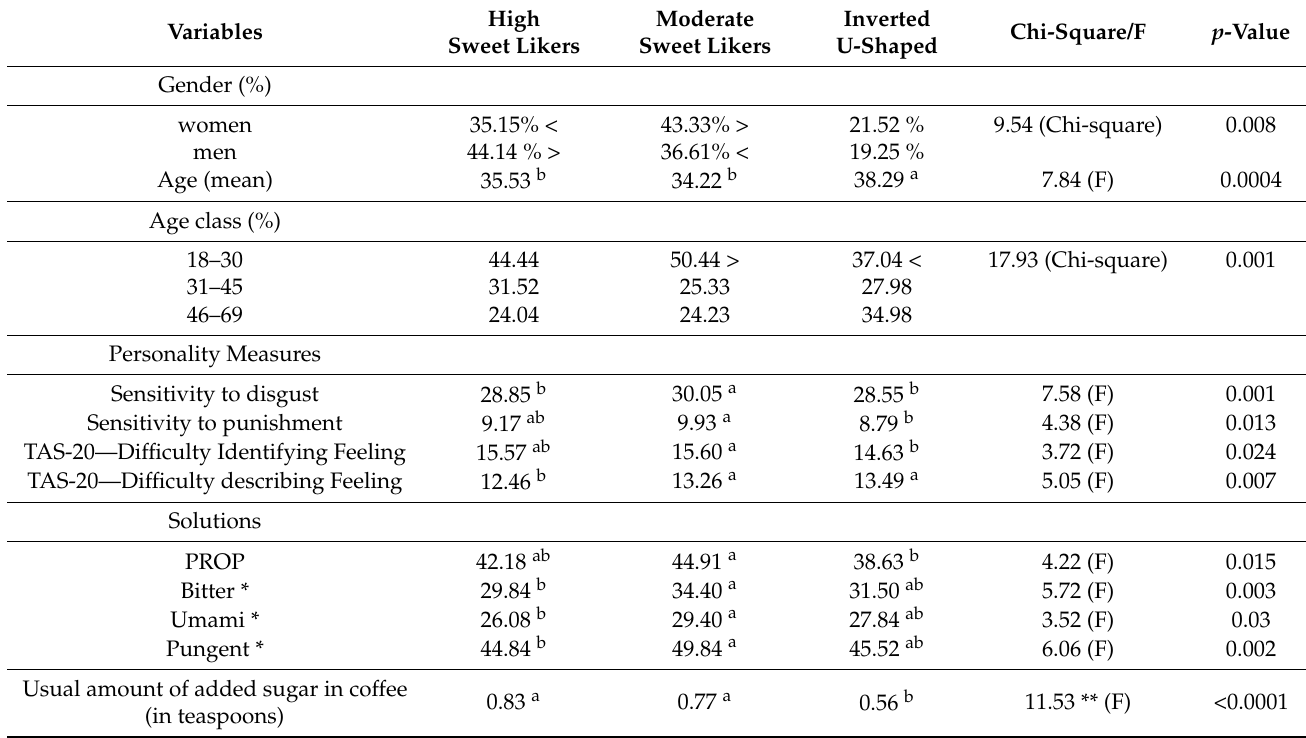
Table 2. Cluster characteristics expressed in percentages (%) or mean values. Only variables that discriminated significantly among clusters were reported ( p <